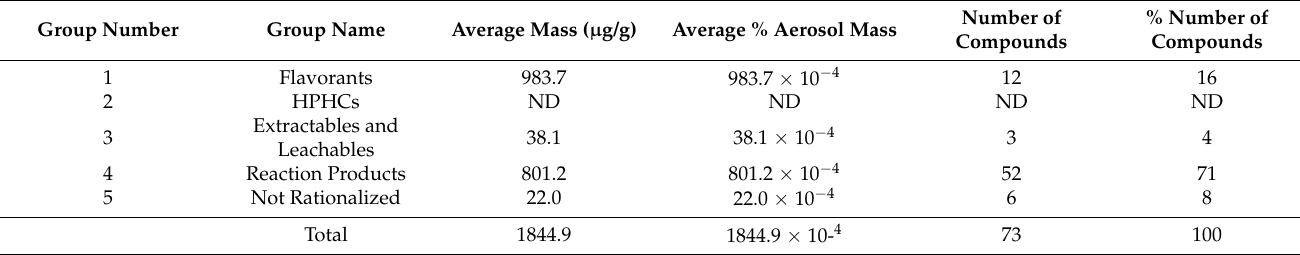
Table 10. Summary of Non-Targeted Analyses in VT5 Aerosol Using the Non-Intense Puffing